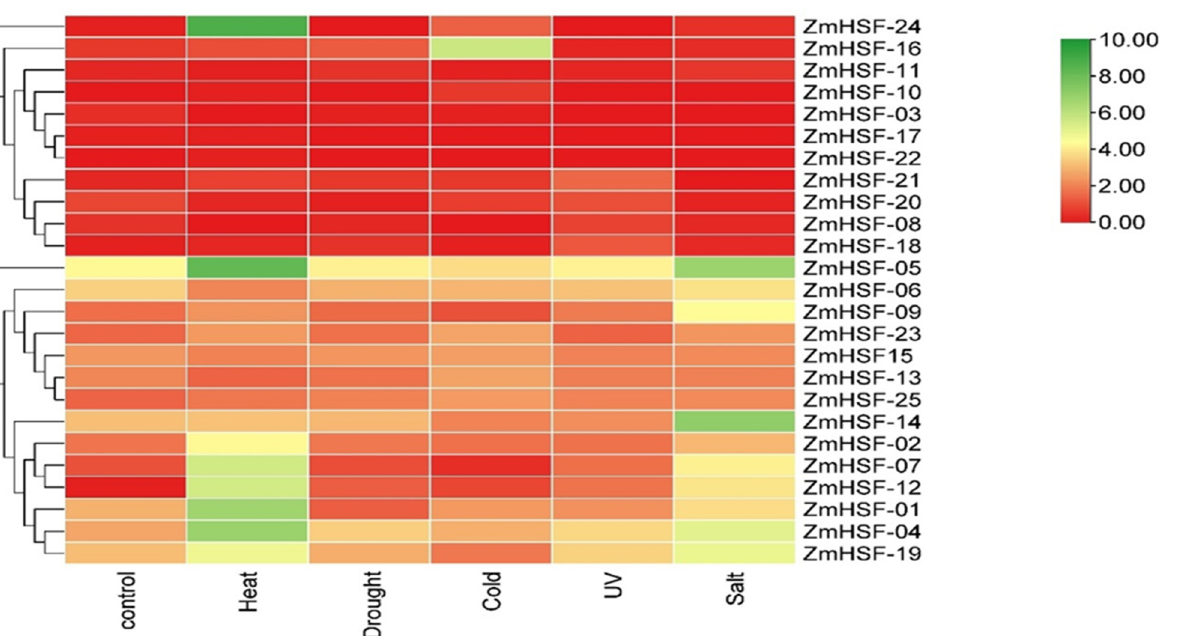
Figure 9. Expression profiles of maize HSFs in different seed ( A ), vegetative ( B ), and reproductive ( C ) tissues based on transcriptome data. The heat map was constructed using Tbtools. The color bar at the top right represents the log trans- formed FPKM values. Green represents higher, red lower, and yellow, medium transcript values.